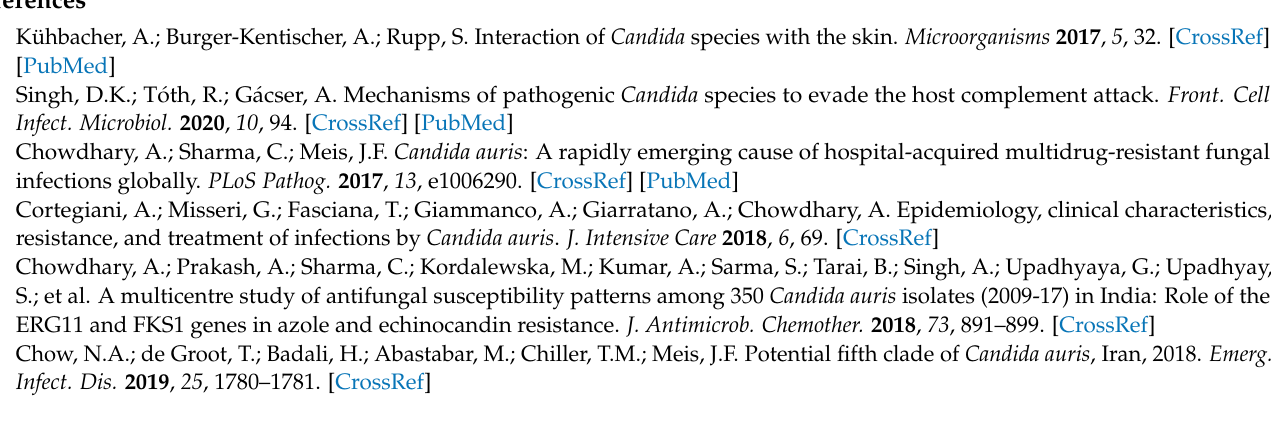
Supplementary Table S1: Overview of strains for each Candida